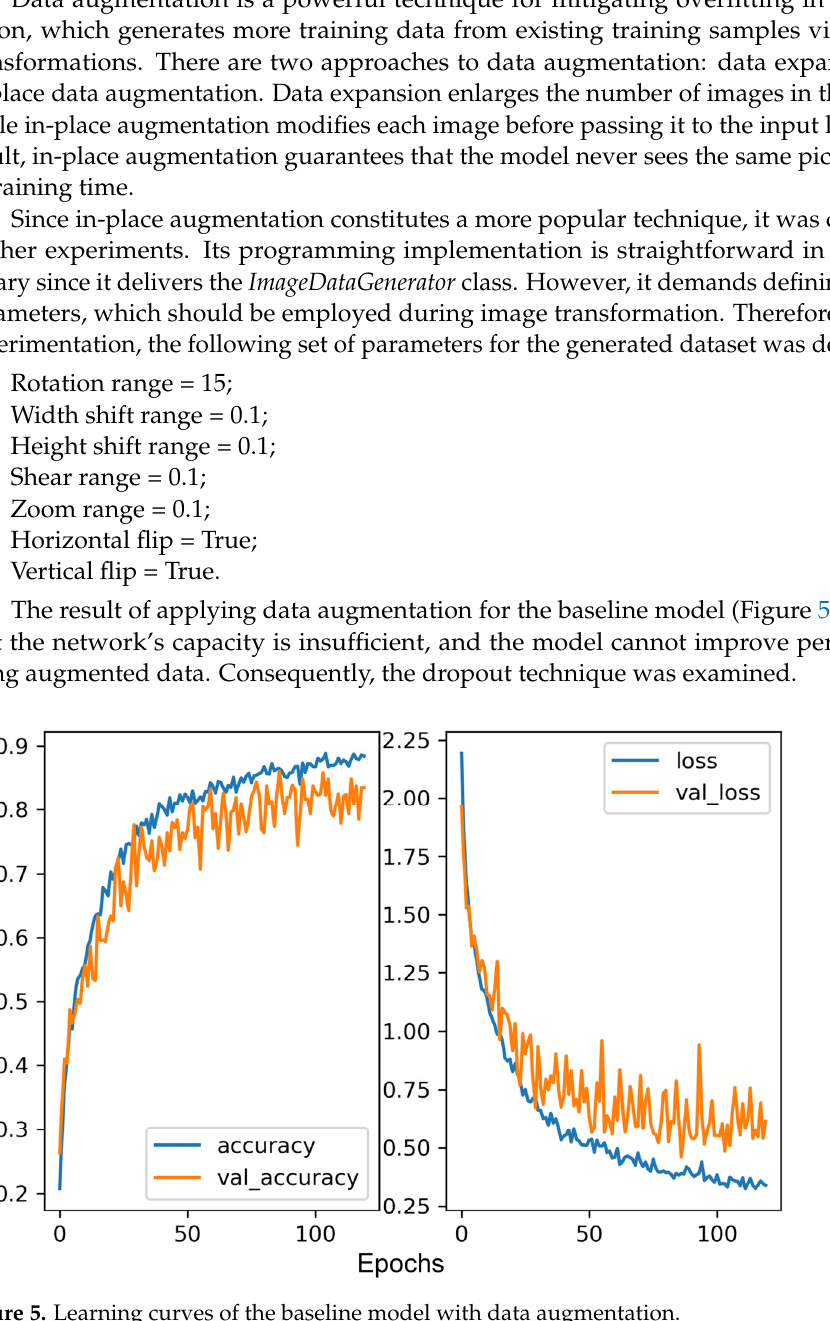
Figure 5. Learning curves of the baseline model with data augmentation.